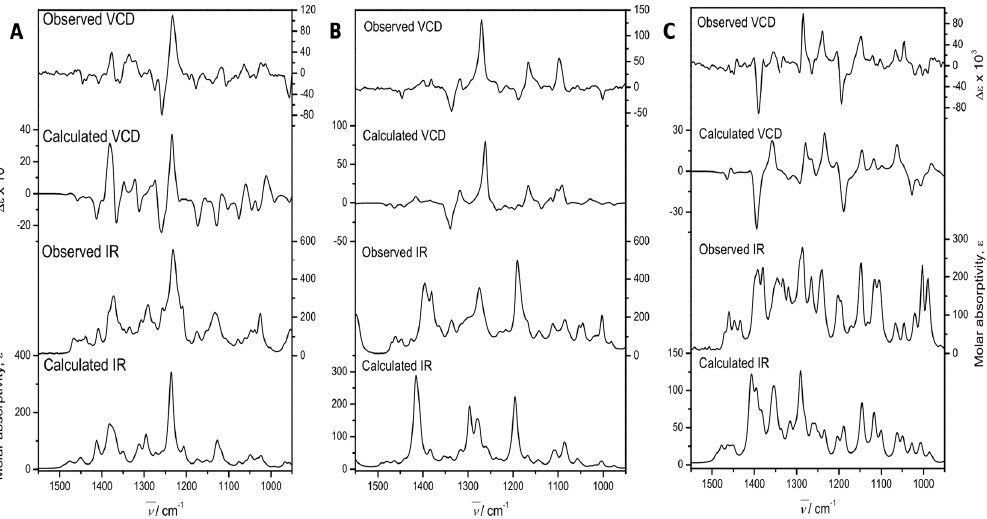
Figure 5. Experimental and Density functional theory (DFT) calculated, at the B3PW91/DGDZVP level of theory, IR, and VCD spectra of 7 α -acetoxy-6,7-dihydroicetexone ( 3 , ( A )), anastomosine ( 6 , ( B )), and 7,20-dihydroanastomosine ( 7 , ( C )).